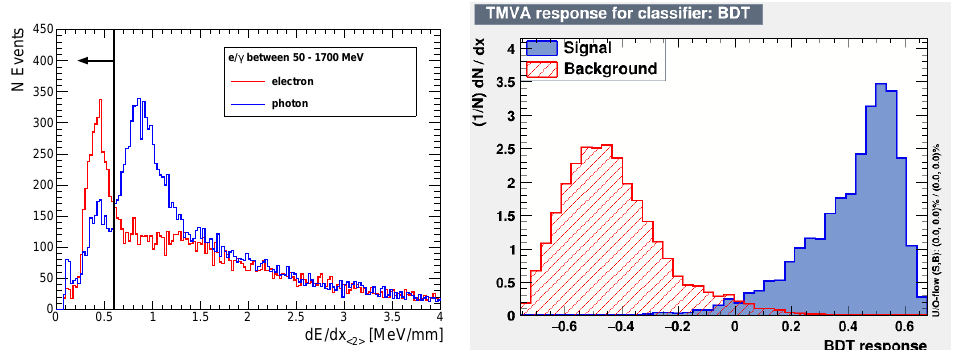
Figure 78. On the ( left ): e / γ discrimination using dE ( right ), BDT classifier output separating 1GeV/c positrons (signal) and protons (background).